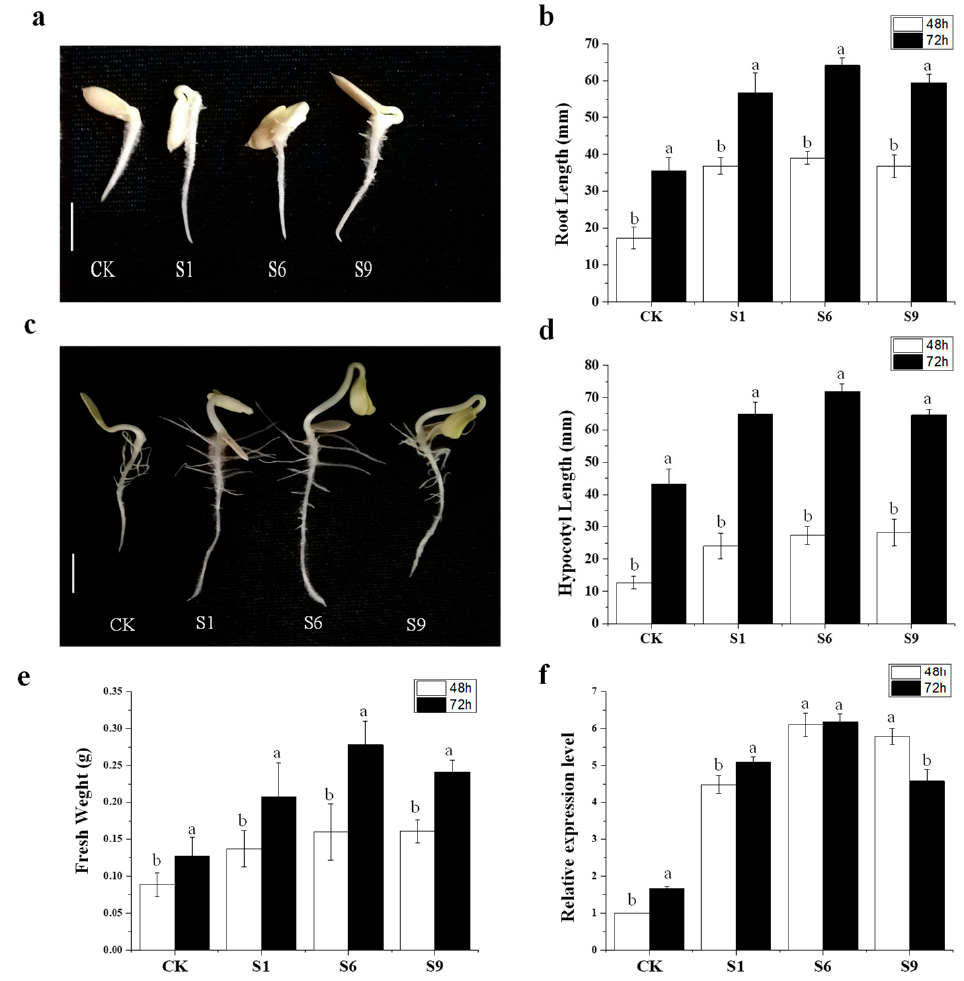
Figure 7. CsSAUR31 regulates root and hypocotyl development in cucumber. ( a ) Root development of the control check (CK) and CsSAUR31 -overexpressing (S) plants at 48 h. ( b ) Root length in CK and S at 48 h and 72 h. ( c ) Root development in CK and S at 72 h. ( d ) Hypocotyl lengths in CK and S at 48 h and 72 h. ( e ) Fresh weights in CK and S at 48 h and 72 h. ( f ) Relative root CsSAUR31 expression levels in CK and S at 48 h and 72 h. The data are the means of three replicates with SEs, and different letters indicate a significant difference ( p < 0.05 by Tukey’s test).